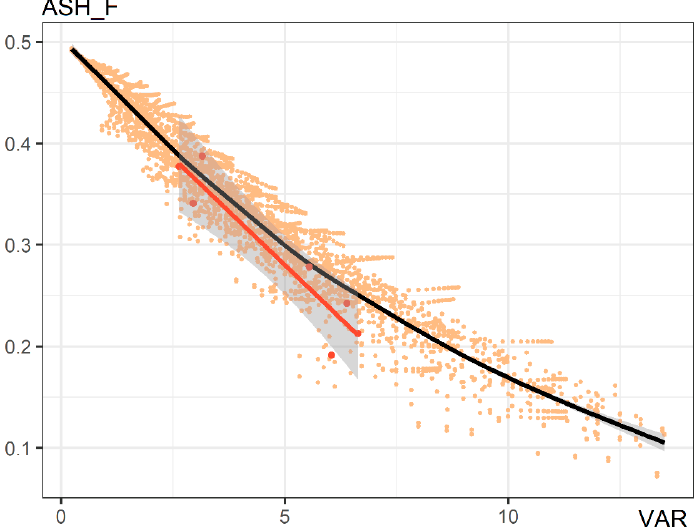
Figure 20. Non-linear regression function of density metric VAR with L-metric ASH_F based on neighbourhood iterations (black line) and case-study-fitted linear regression line (red) with 95% CI in grey.